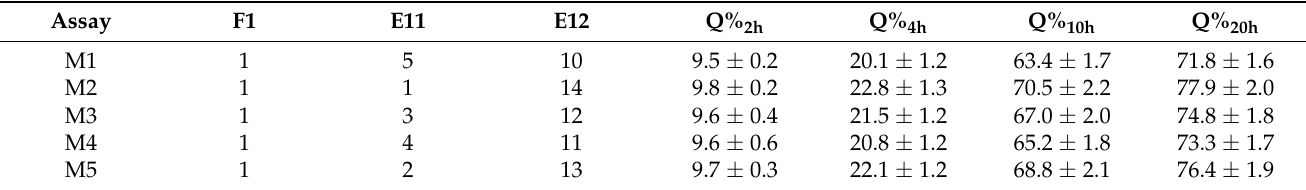
Figure 6. Simulated dissolution profiles for the mixtures of F1, E11, and E12 mini-tablets using Equation (2). Table 7. Responses used to optimize the dissolution profile of MS. The values are expressed by the average of three determinations. In addition, the values of F1, E11, and E12 represent the number of mini-tablets used.